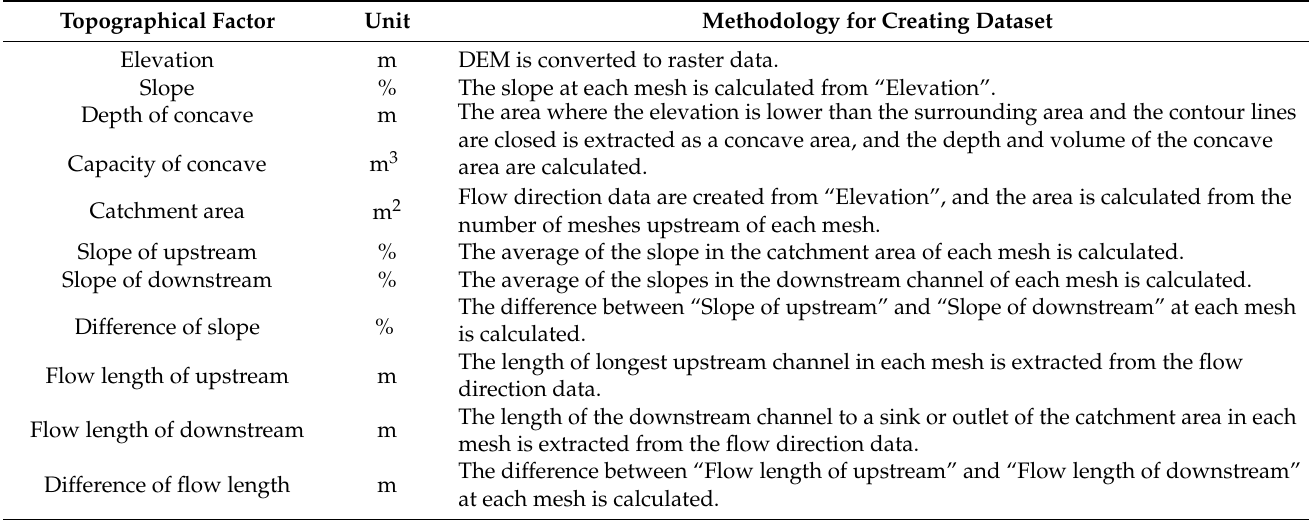
Table 3. The method used to create each topographical factor. Topographical Factor Unit Methodology for Creating